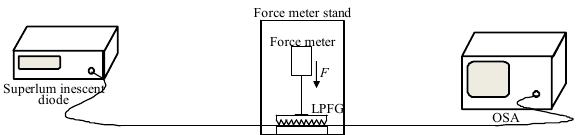
Fig. 2 Experimental setup of LPFG fabricated by 3D printed LPFG device.